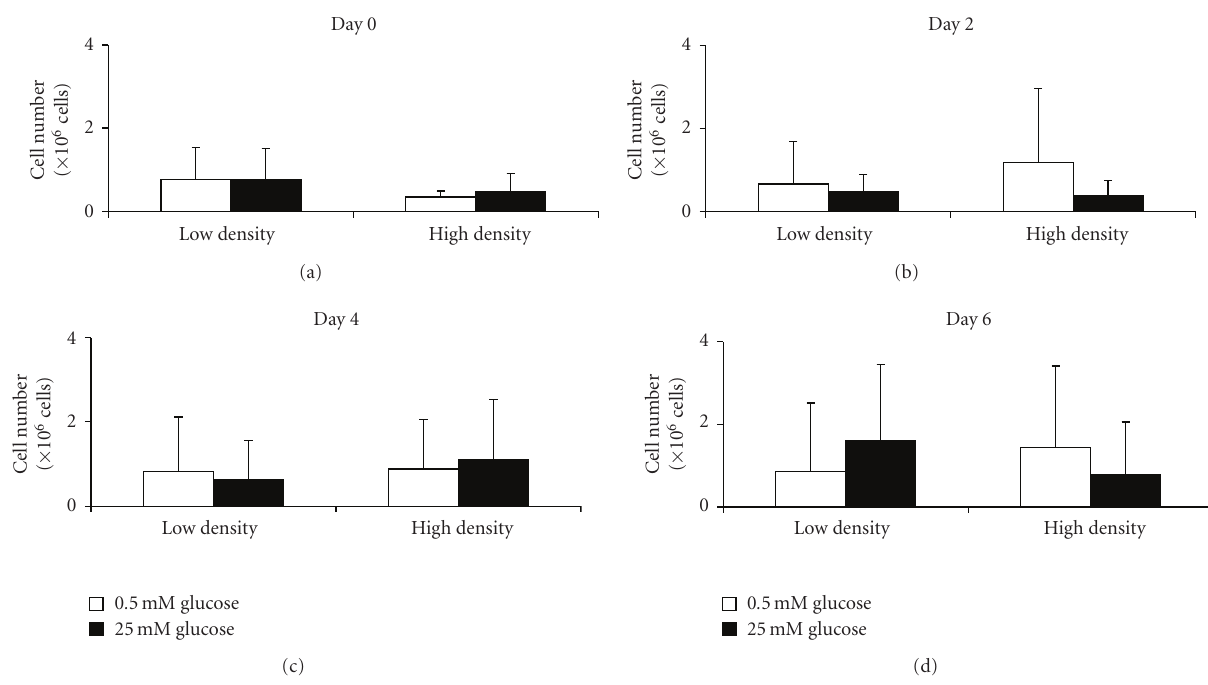
Figure 2: Cell population (mean ± standard deviation) over the course of six days while in three-dimensional culture ( n = 12 per group). Culturing the cells within the di ff ering three-dimensional environments did not produce any particular trend in the cell population. Statistical significance was not observed at the P = . 05